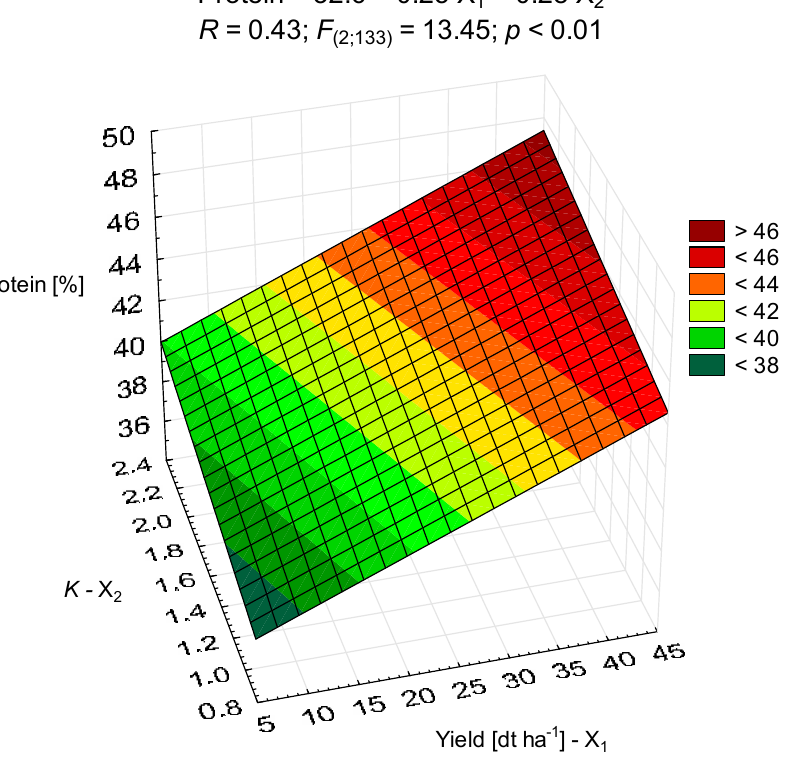
Figure 5. The relationship between soybean protein content (%), seed yield (dt ha − 1 ) and hydrother- mal coefficient ( K ).